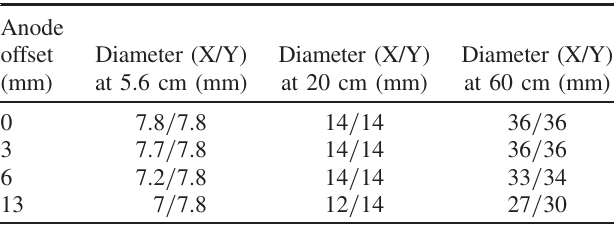
TABLE IV. Beam size (100% of the simulated ensemble) at the exit of anode (5.6 cm), at the center of 1st X corrector magnet (20 cm) and at the entrance of the solenoid (60 cm) downstream for various offset anode